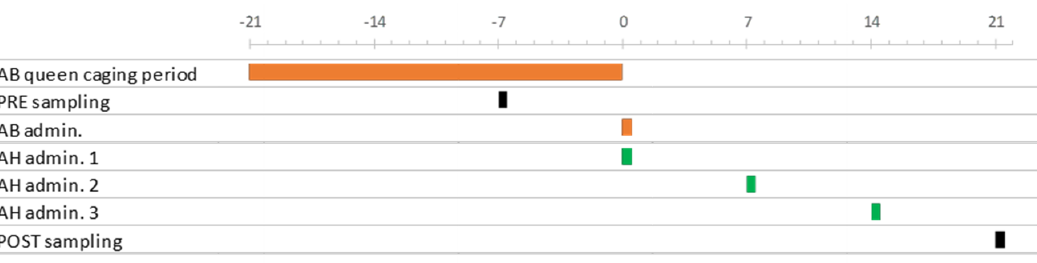
Figure 1. Summary of the working schedule. The horizontal axis represents the timeline, with day 0 corresponding to the 6 October 2017. AB (orange) and AH (green) indicate respectively the Api-Bioxal- and ApiHerb-treated groups.